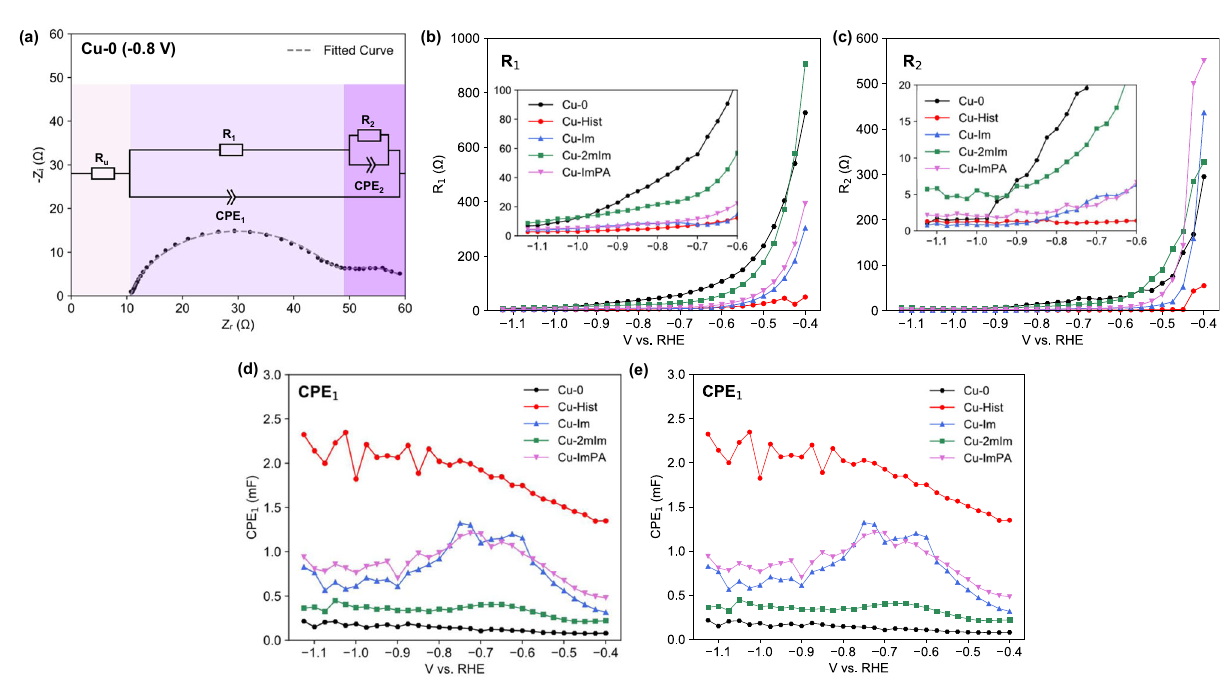
Fig.6|EvaluationoforganicfunctionalisedCucatalystsusingEISmeasurementatcatalyticallyrelevantDCpotentials.a TheequivalentcircuitusedforEISspectra fi tting. Numerical data fi tting results of EIS spectra measured on fi ve samples across different DC potentials: b R